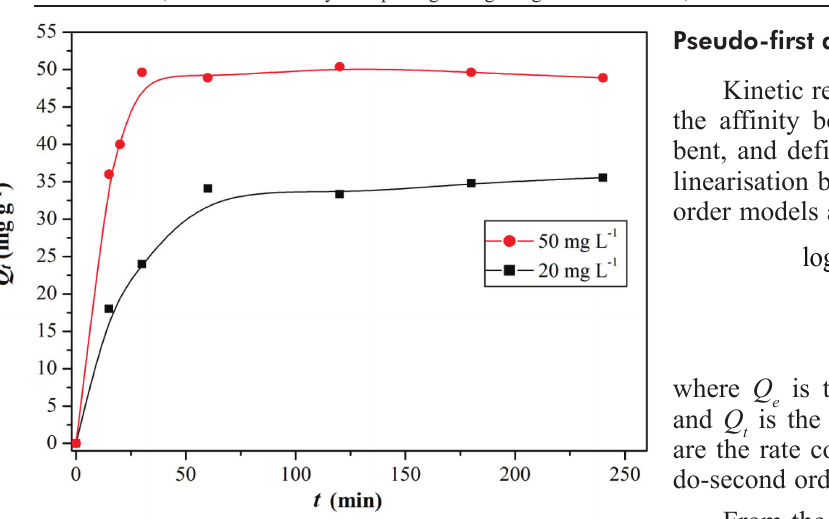
Fig. 3 – Kinetics of retention of CA by 30 mg of CLDH at initial concentrations (20 mg L –1 and 50 mg L –1 )